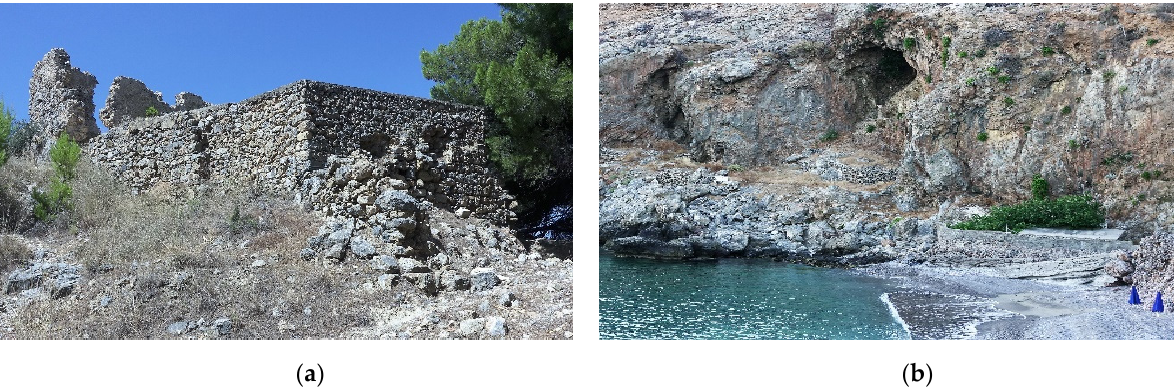
Figure 13. Water supply of Chora of Sfakia: ( a ) Venetian rainwater cistern and ( b ) costal spring (photos by A. N. Angelakis).